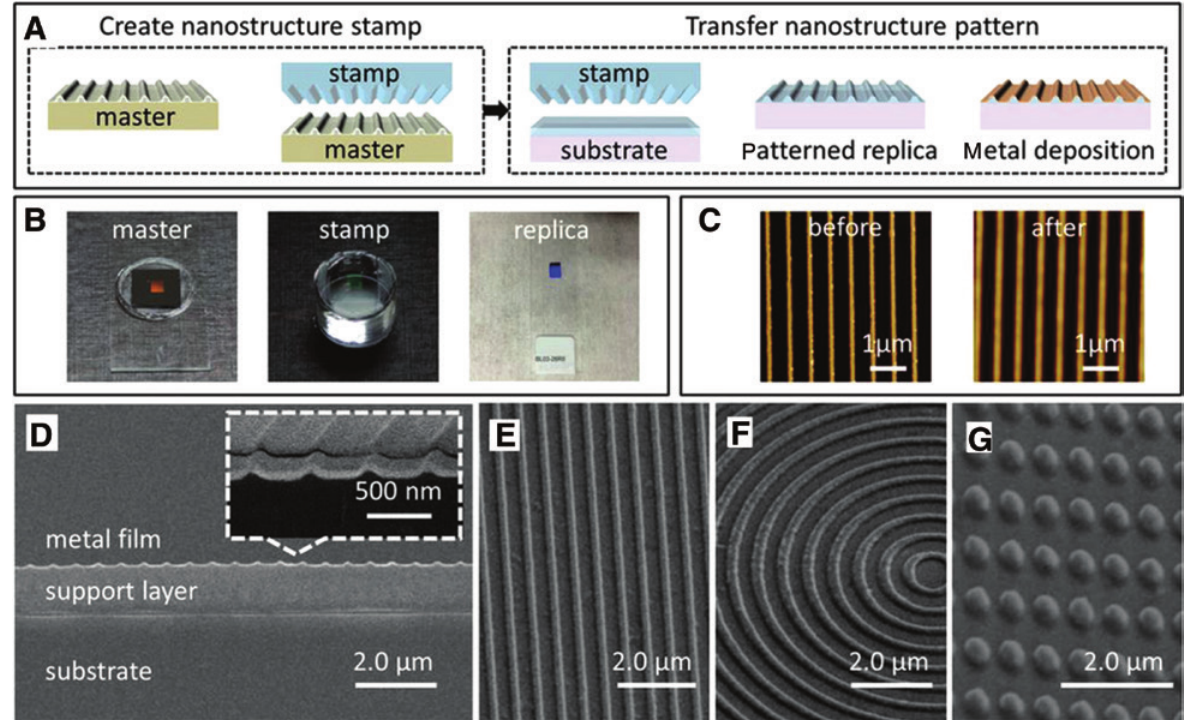
Figure 8: Large-scale and high-throughput nanofabrication technique for nanoscale patterns with different designs. Combining the features of nanoimprint and soft lithography, nanostructures could be reproduced rapidly in large amounts for chip devices. (A) Fabrication process flow diagram. (B) Pictures of an EBL patterned master on the silicon substrate, a poly(N,N-dimethylacrylamide) (PDMA) stamp, and a nanostructure replica with a gold thin film layer on a glass slide. (C) Atomic force microscopic images showing the surface morphology of an EBL patterned master (before) and a stamped replica (after) (D). Scanning electron microscopic (SEM) images of a cross section of the structure. (E) A nanograting struc- ture. (F) A bulls-eye structure. (G) A silver array of ~ 250-nm-diameter nanodots spaced every 600 nm. Reprinted with permission from Ref.